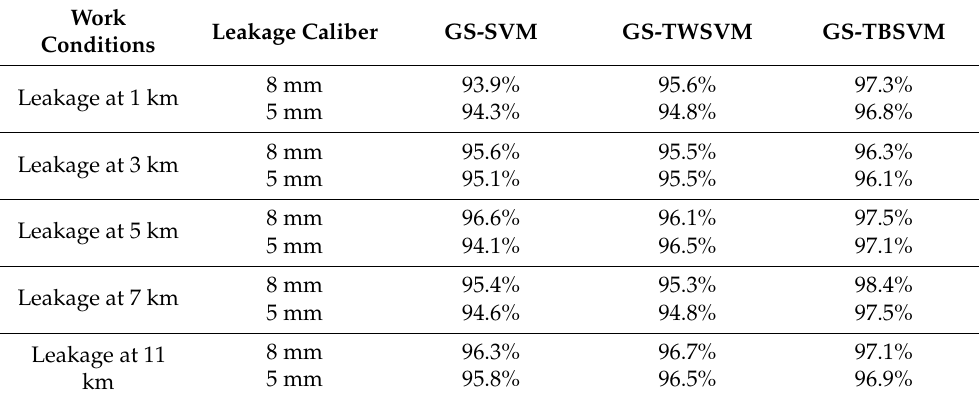
Table 2. The FAR and FDR of IRPCA-based and PCA-based leak detection